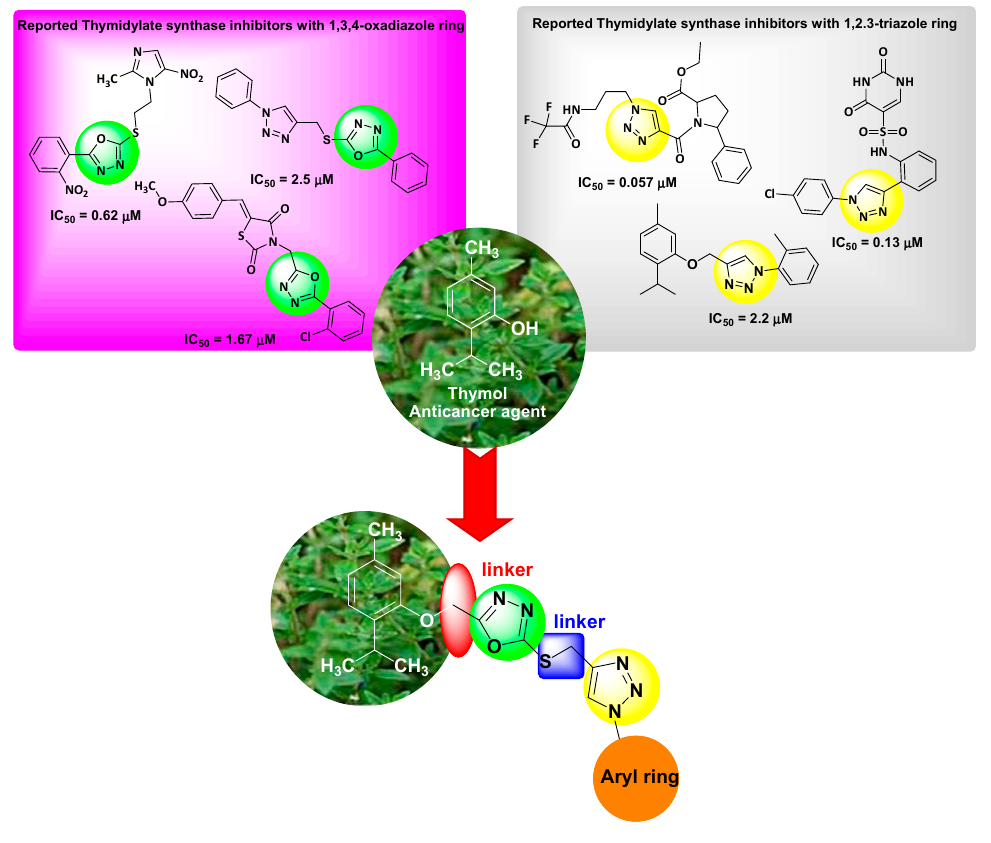
Figure 1. Rationale for the present work.